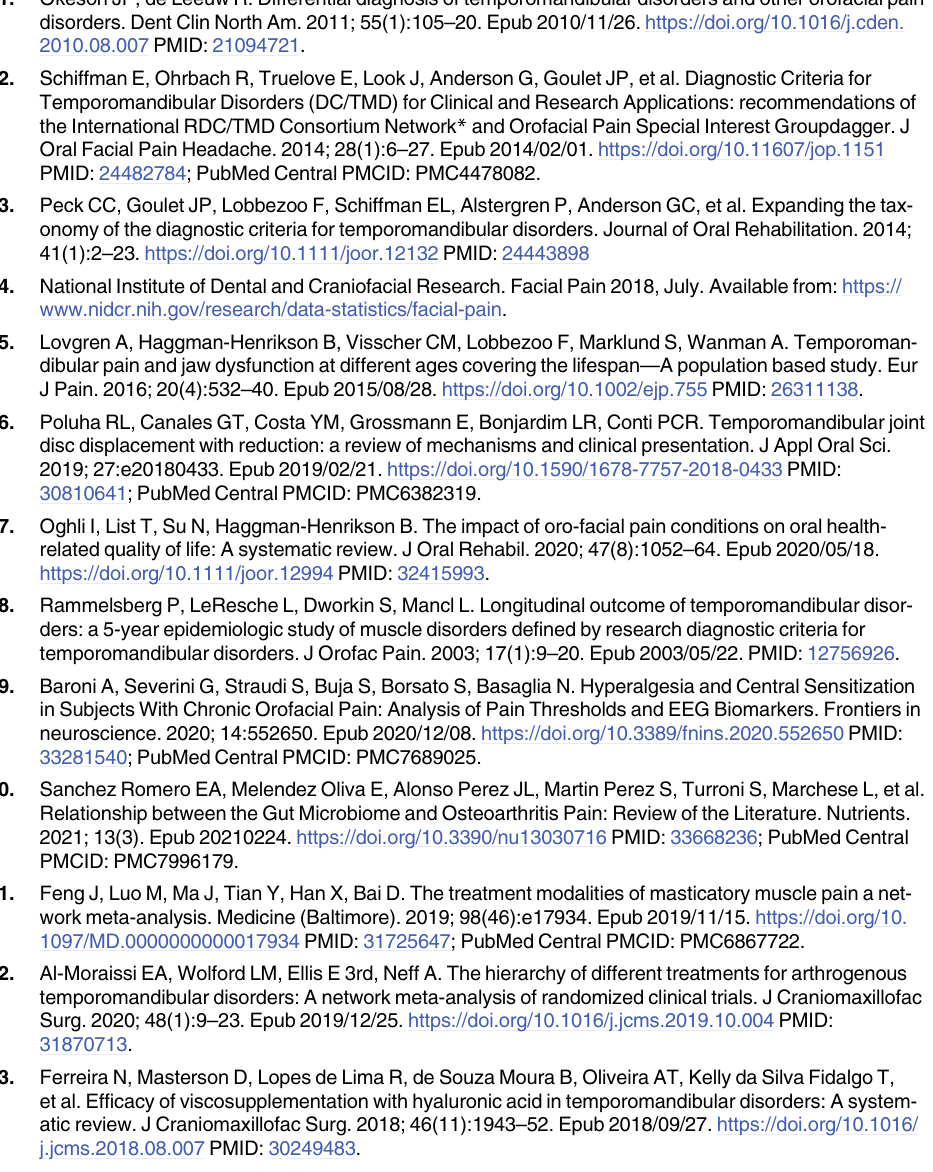
S2 Table. PRISMA-P (Preferred Reporting Items for Systematic review and Meta-Analysis Protocols) 2015 checklist: Recommended items to address in a systematic review